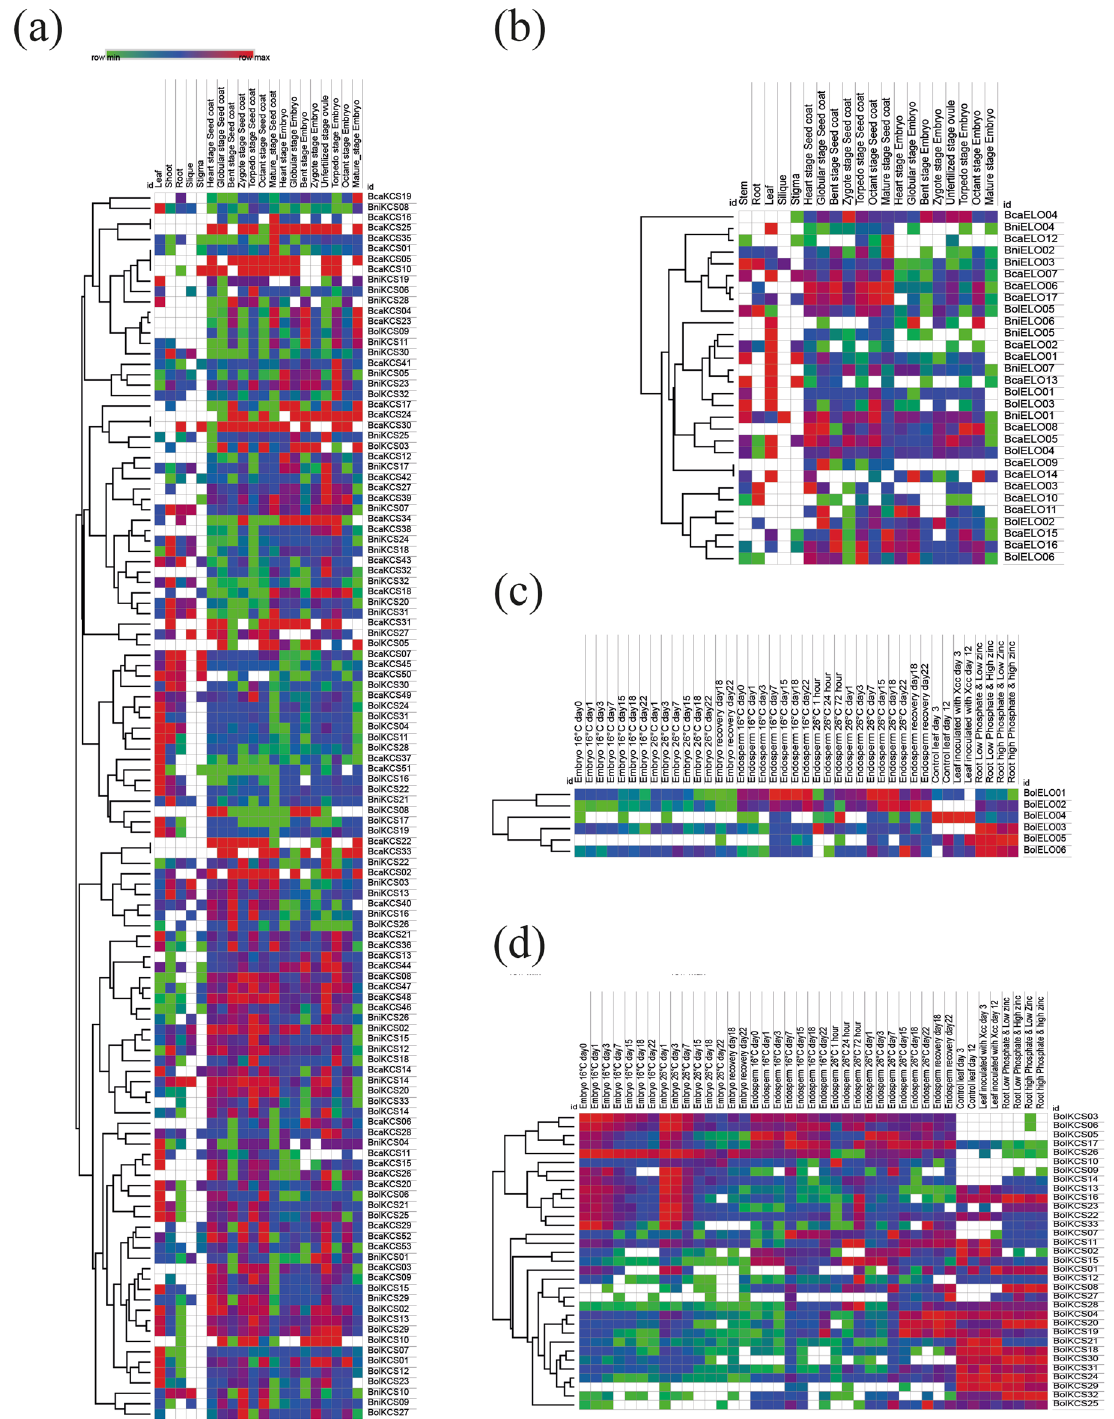
Figure 5. RNA-seq analysis based heat map of the identified KCS and ELO members: ( a ) KCS and ( b ) ELO genes expressions in different plant tissues of B. carinata , B. nigra and B. oleracea . The ( c ) ELO and ( d ) KCS genes expression levels under biotic and abiotic stresses in B. oleracea